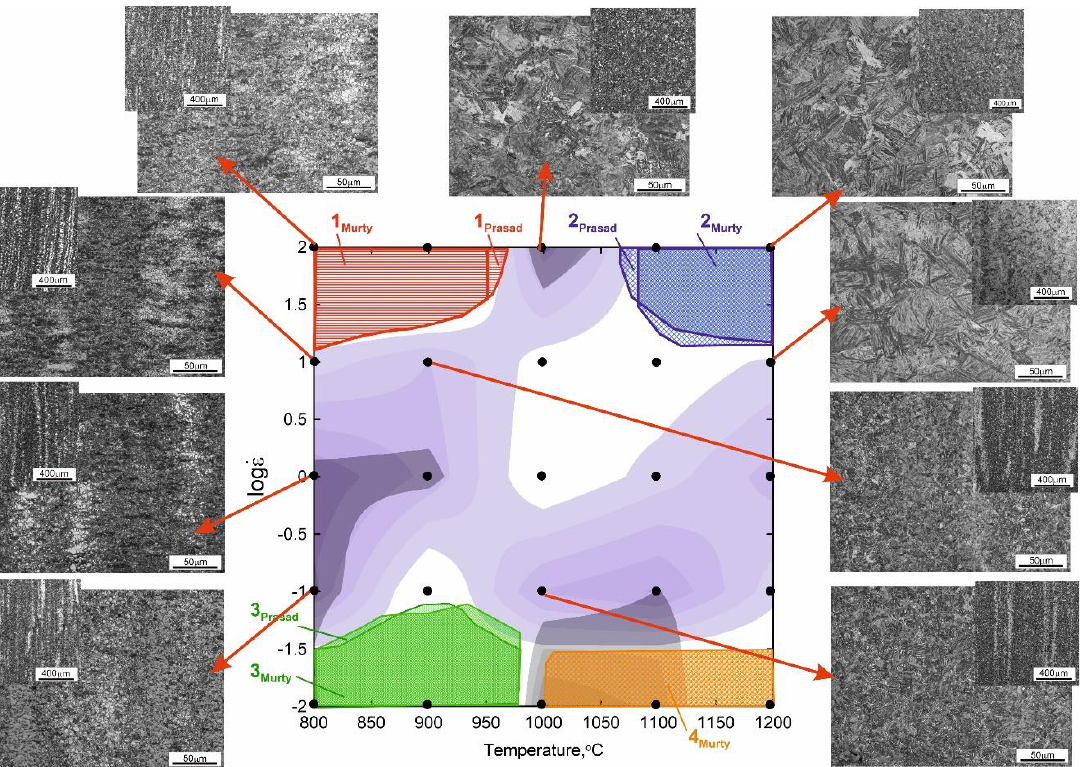
Figure 5. Complex processing map combining all the analyzed flow–stability criteria correlated with characteristic microstructural changes observed in the deformed samples. The areas in gray shades correspond to the material flow instability parameters. White areas correspond to processing parameters leading to stable material